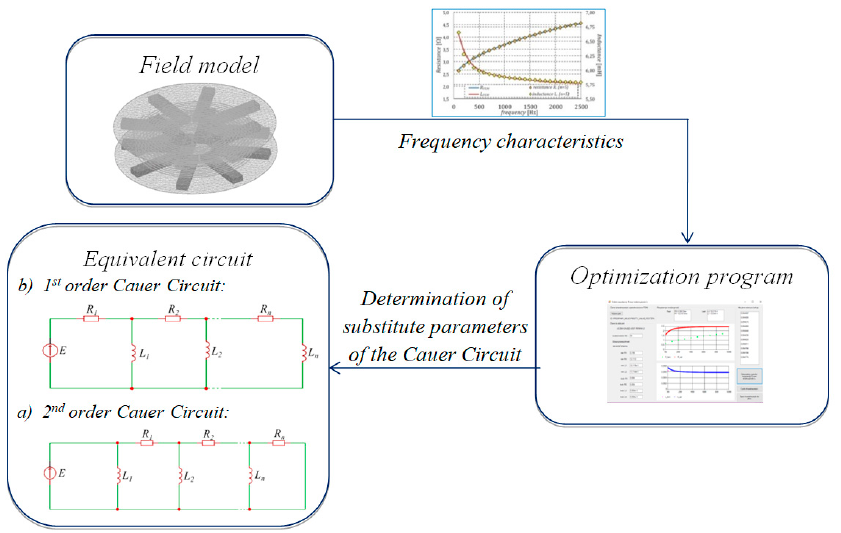
Figure 2. Algorithm for equivalent model (EqM) synthesis.